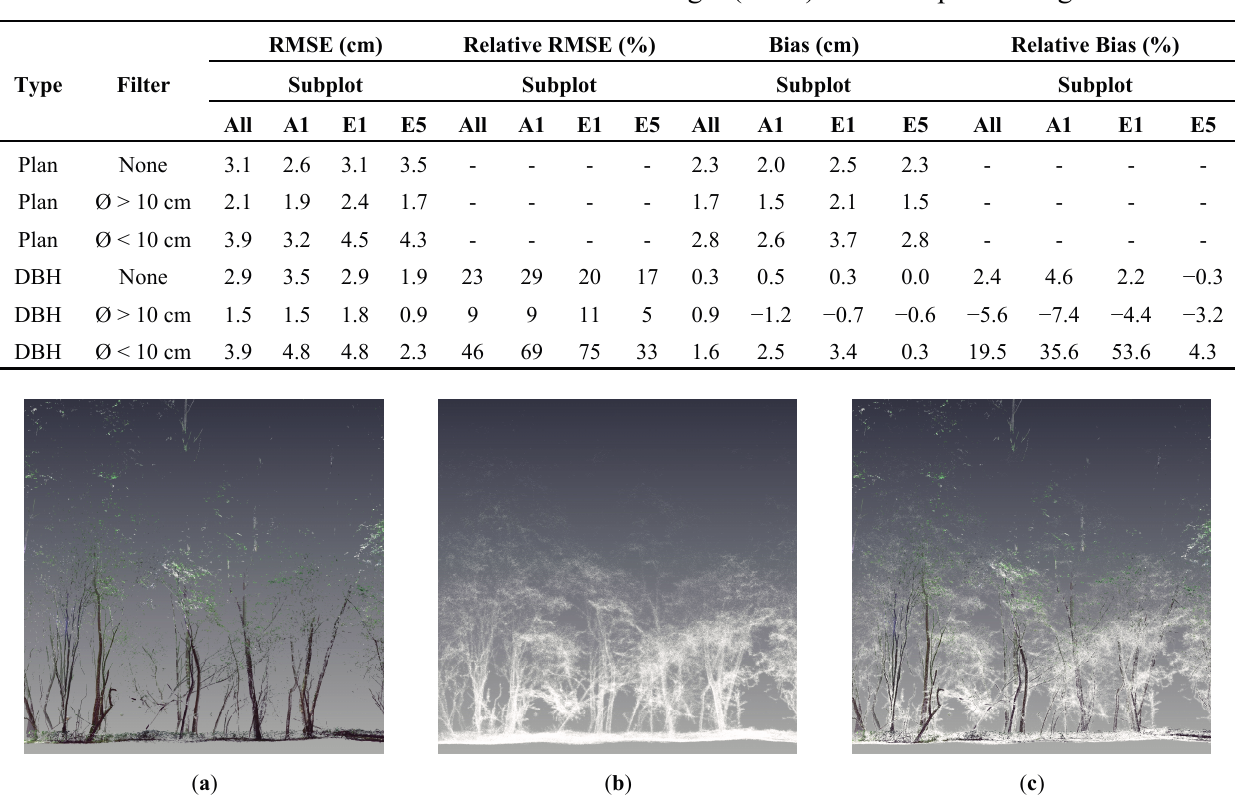
Table 4. Accuracies of diameter at breast height (DBH) and stem positioning.